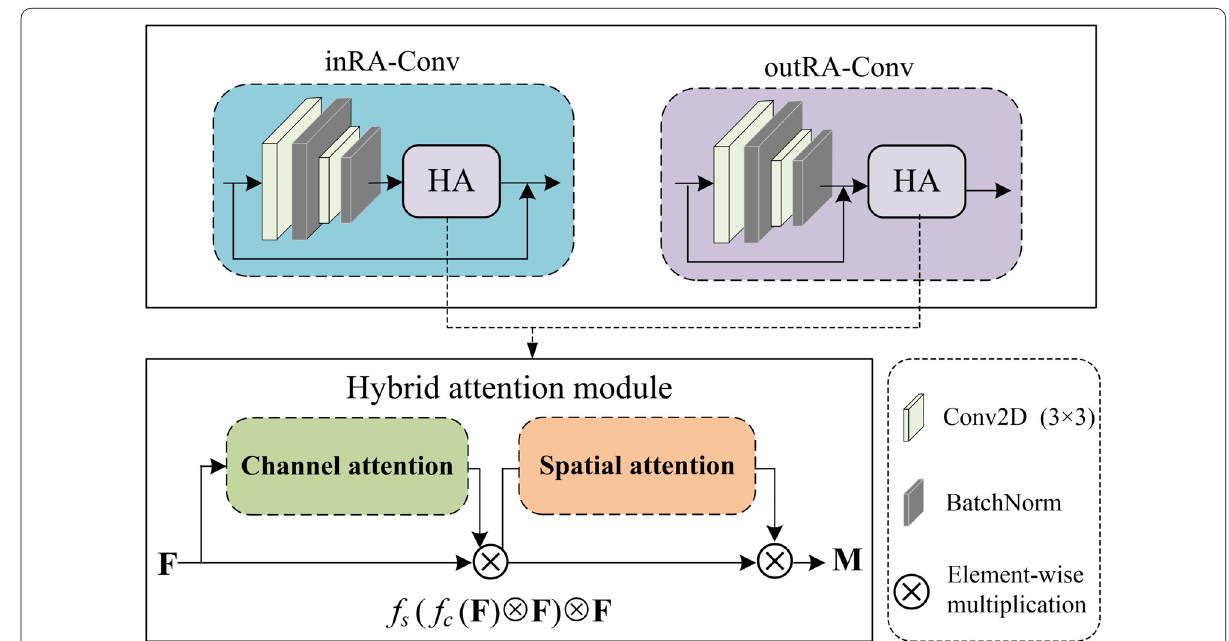
Fig. 4 Structure of residual convolution with hybrid attention